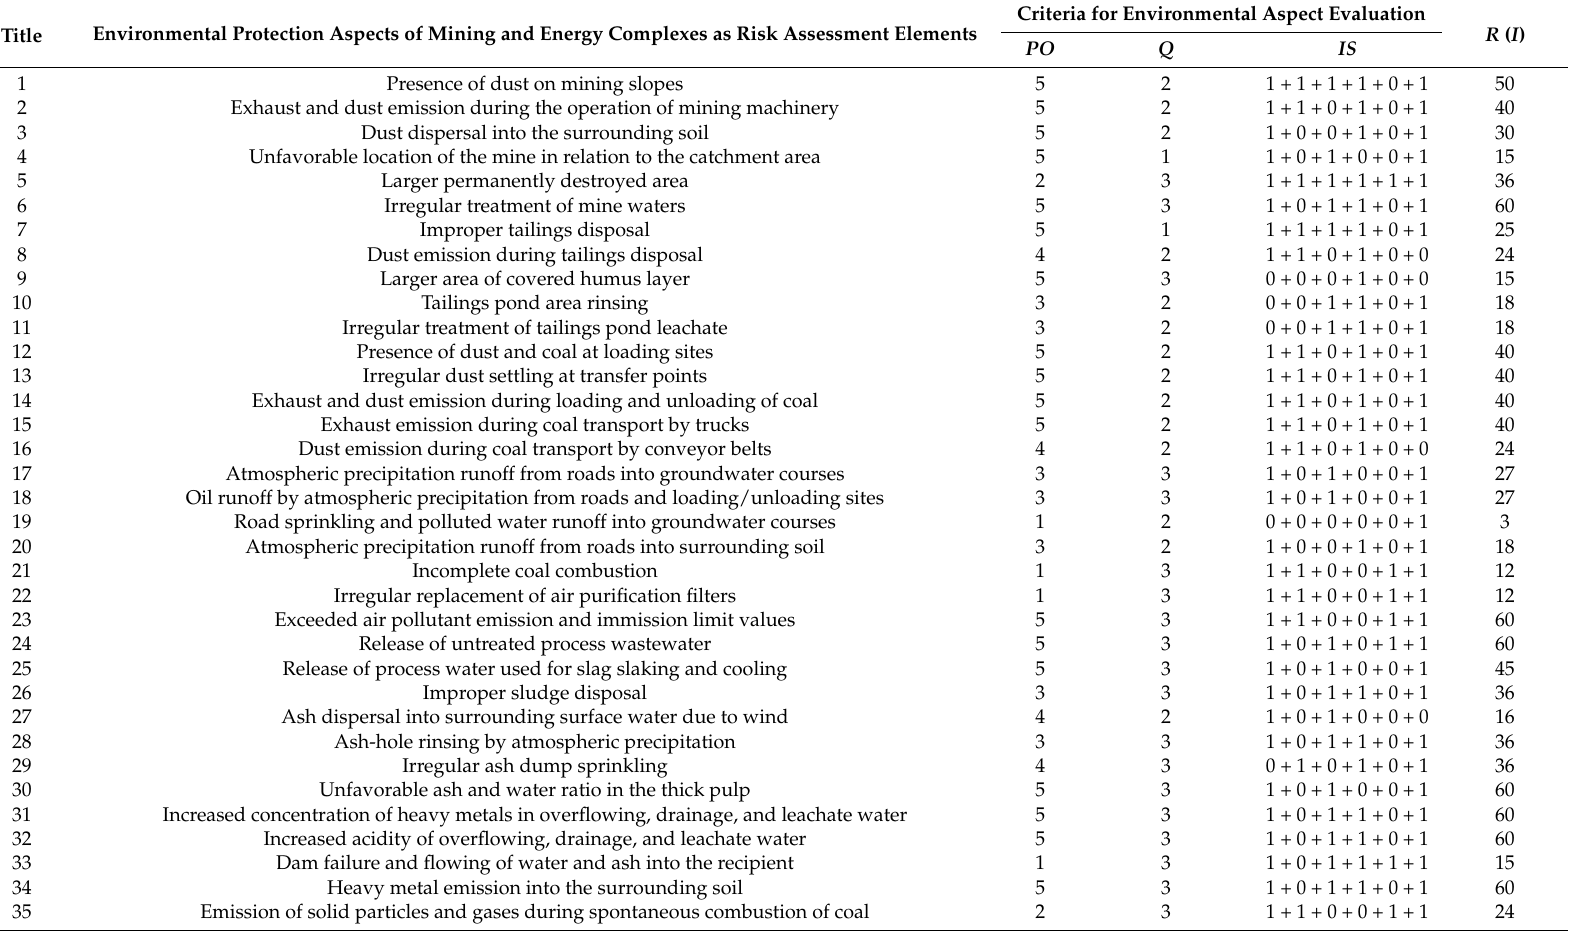
Table 4. Determination of environmental aspect importance ( I ) based on probability of occurrence ( PO ), quantity ( Q ), and impact seriousness ( IS